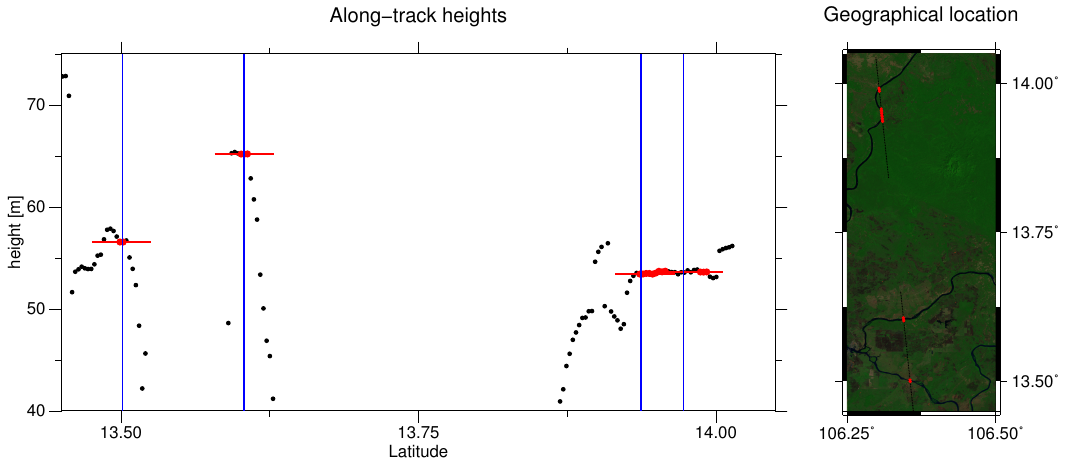
Figure 7. Heights along one track which crosses a river at four locations. The map on the right side shows the geographical surroundings with the background as a Landsat-8 scene where the rivers are well visible. The black dots are all retracked heights with the red dots indicating which measurements were classified as water. The blue vertical lines show the location of the crossing of the track with the river polygon and the horizontal lines are the estimated water level at each